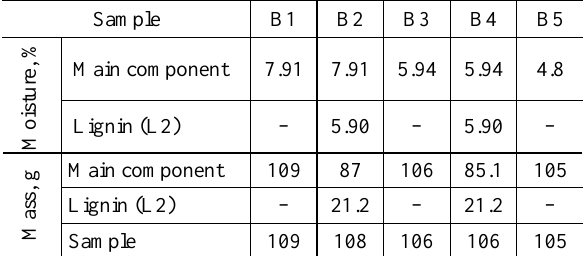
Table 2. Moisture and outweigh mass of components of the board samples